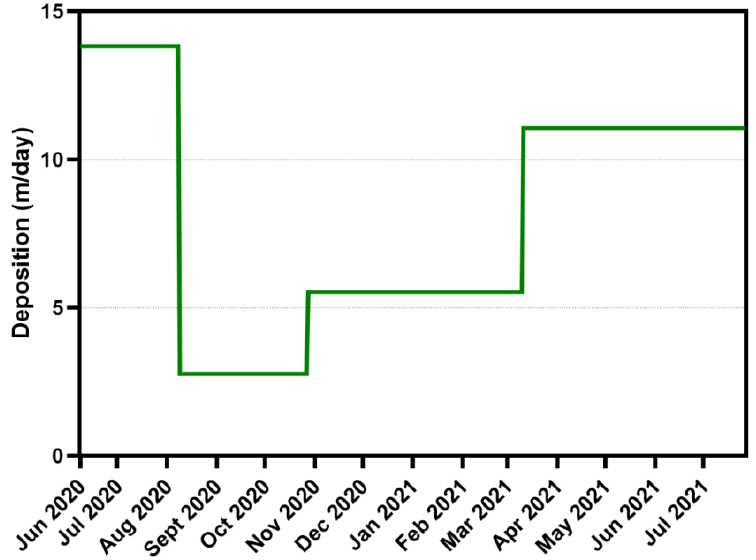
Figure 3. Calibrated deposition curve for both trace metals Cu and Ni.